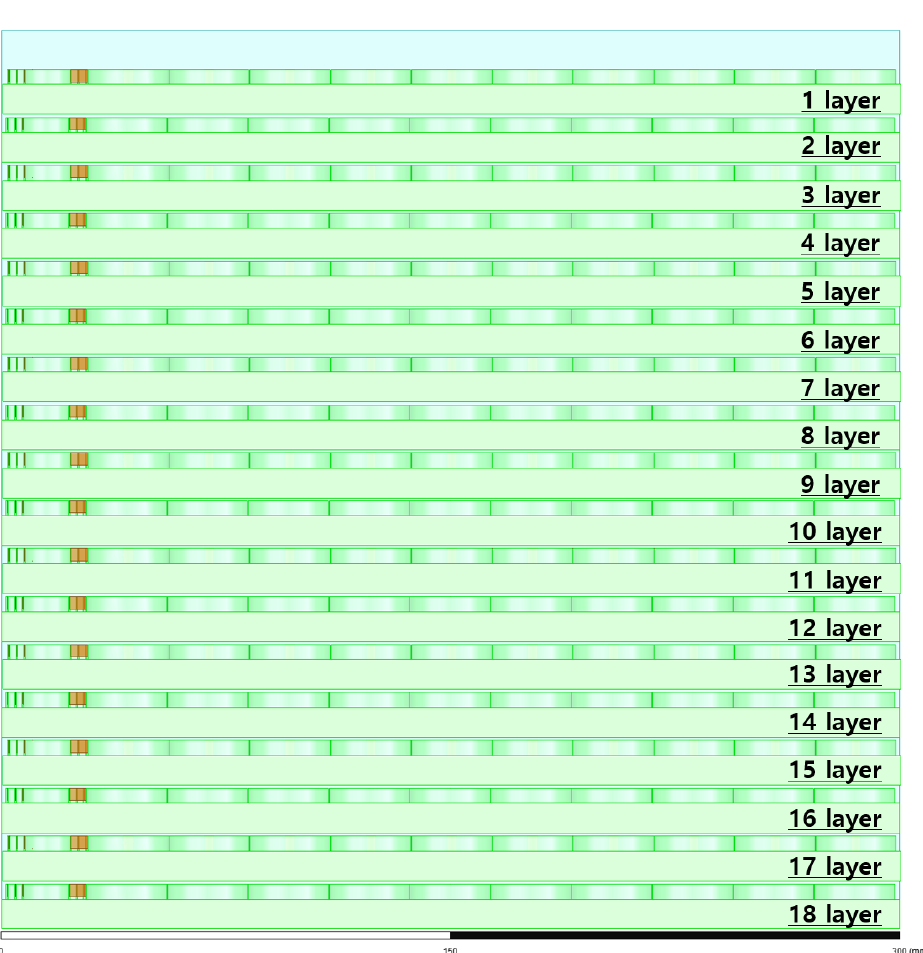
Figure 7. Bifilar-meander-type superconducting current module designed in a standard box.